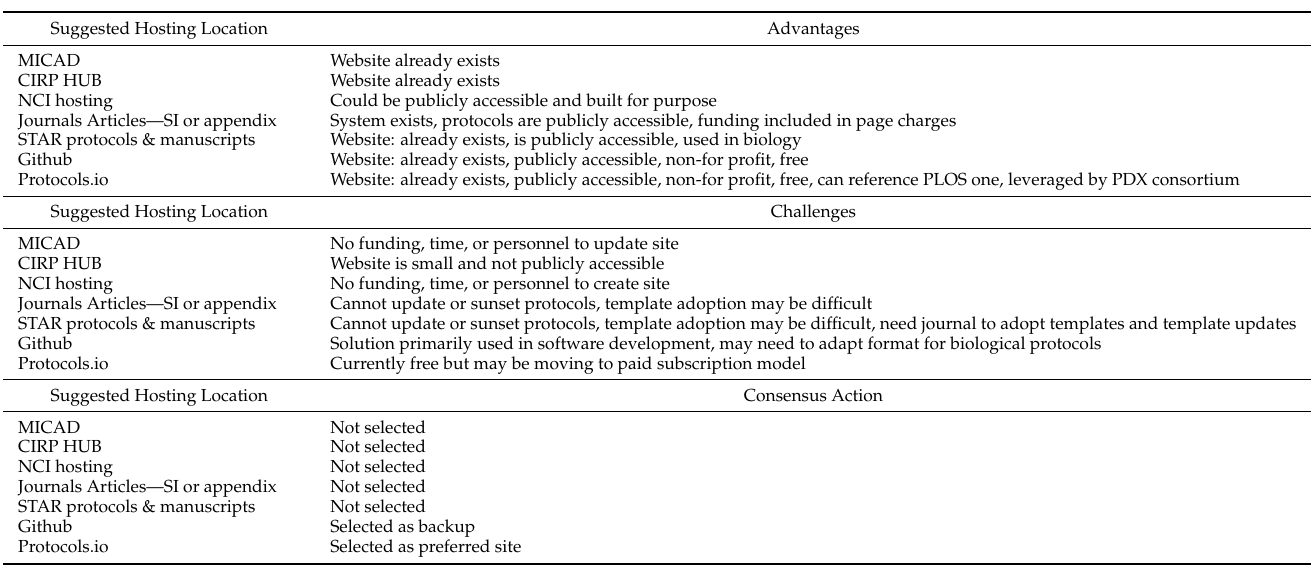
Table 1. Key discussion points and actions around locations to house pre-clinical protocols and